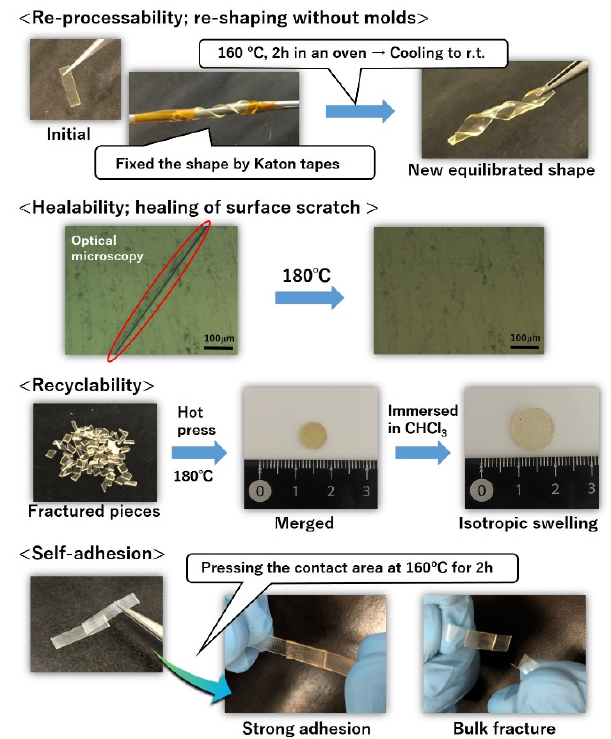
Figure 7. Representative functions of vitrimers, where the vitrimer sample was the amorphous low T g polyester-based vitrimer reported by M. Hayashi et al. from ref. [26]. Reproduced/adapted by permission of The Royal Society of Chemistry.